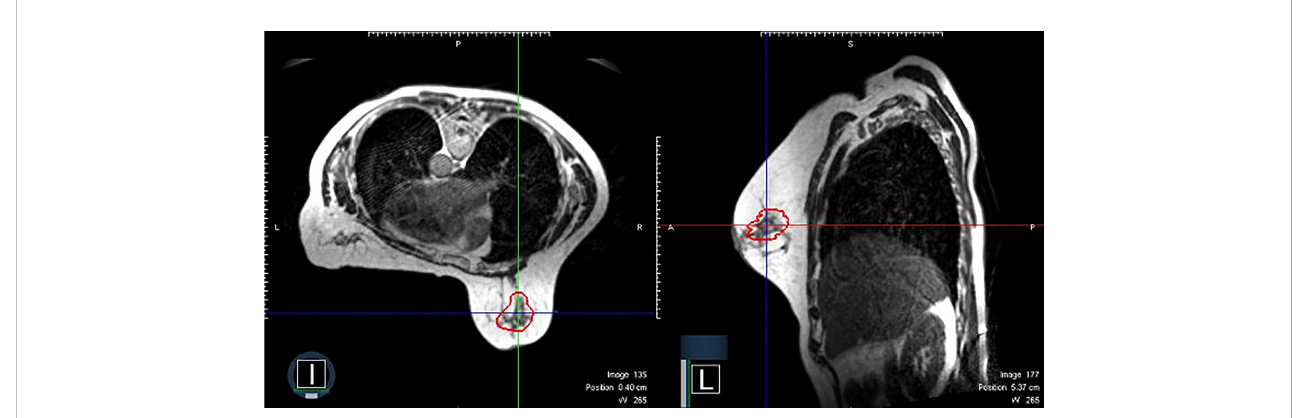
FIGURE 1 An example of clinical MRI-Linac images utilized for therapy guidance. The panel on the left shows a patient receiving prone breast irradiation with an MRI image in the axial plane. The same patient with a sagittal plane image. The red contour depicts the lumpectomy surgical cavity which serves as the clinical target